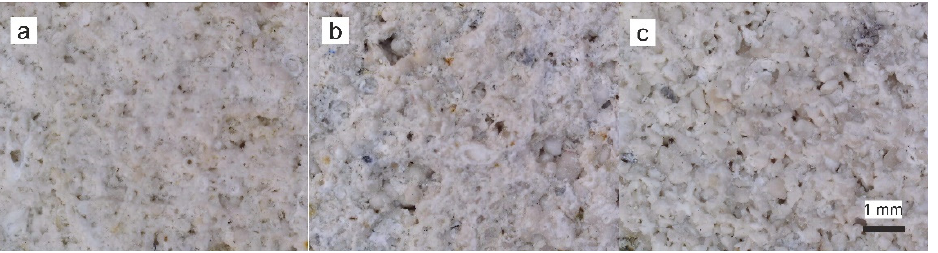
Figure 4. Consolidate agent properties according to the manufacturer (* data from Remmers tech- nical datasheets; ** data from Safety data sheet). Table 1. Composition of the tested consolidants according to safety data sheets from producer (Rem- mers Gmbh). KSE 100 KSE 300